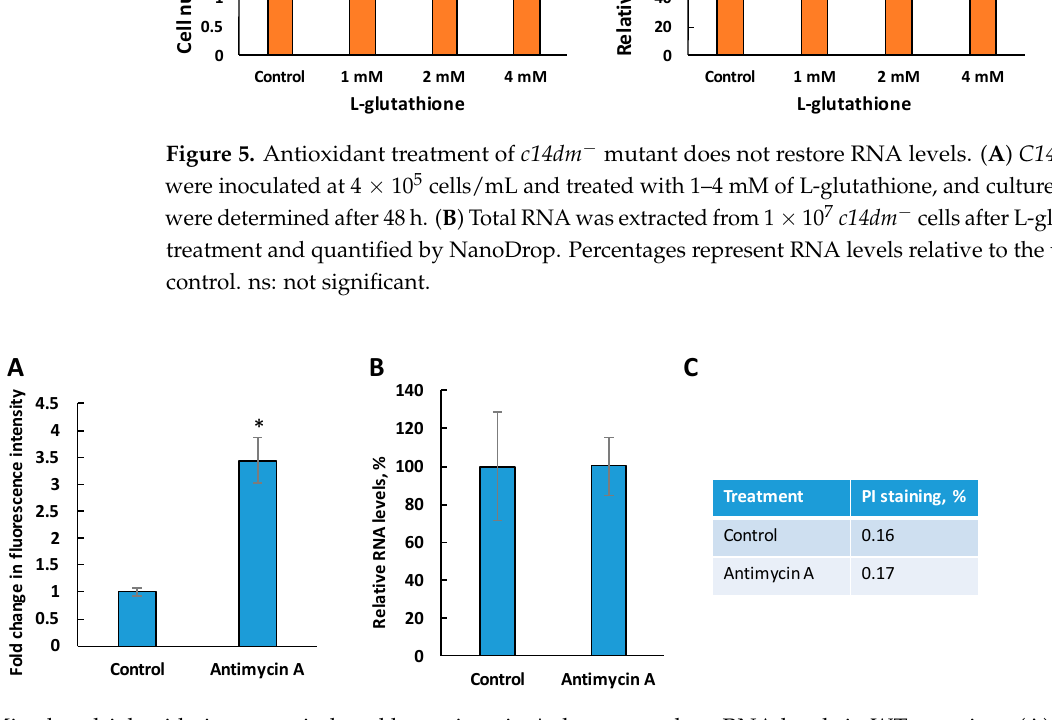
Figure 6. Mitochondrial oxidative stress induced by antimycin A does not reduce RNA levels in WT parasites. ( A ) WT parasites were treated with antimycin A for 3 h at 27 °C and stained with 10 μ M of MitoSox Red. Mean fluorescence intensities were determined by flow cytometry. Relative mitochondrial ROS levels were plotted in comparison to untreated WT control cells. ( B ) Total RNA was extracted from 1 × 10 7 WT cells after antimycin A treatment and quantified. Percentages represent RNA levels relative to the untreated control. ( C ) Cell death was measured by PI staining. *: p < 0.05;.